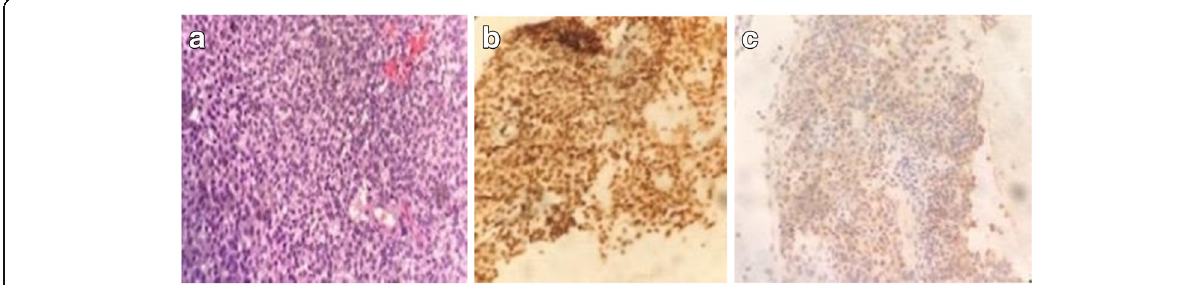
Fig. 1 All pictures taken under magnification ×40 using microscope Olympus BX43. a The tumor consists of uniform small round blue arranged in sheets. b Tumor cells positive for FLI-1. c Tumor cells positive for CD99